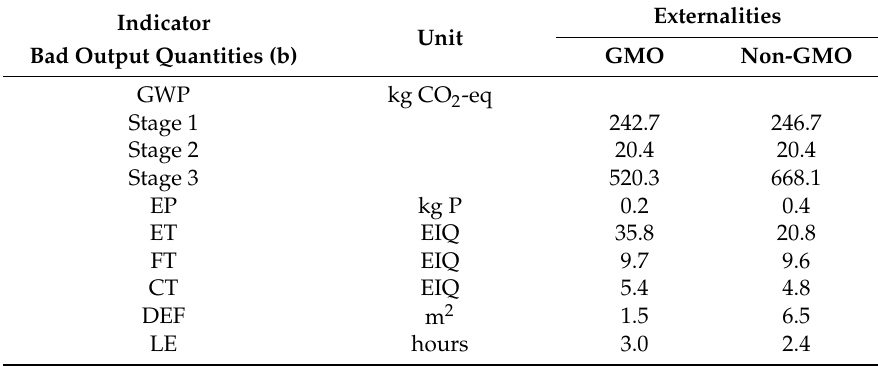
Table 3. Bad outputs of externalities in rice